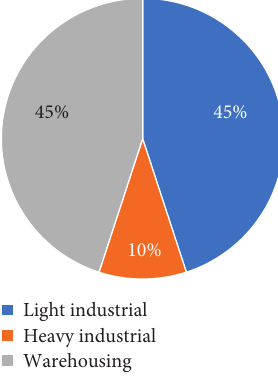
Figure 2: Main activities performed in the industrial buildings in Portugal.